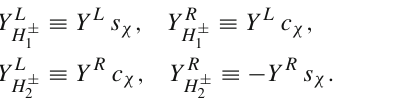
Table 2 Values of the input parameters considered in the numerical scan λ = 0 . 26 m 1 λ = 0 . 2